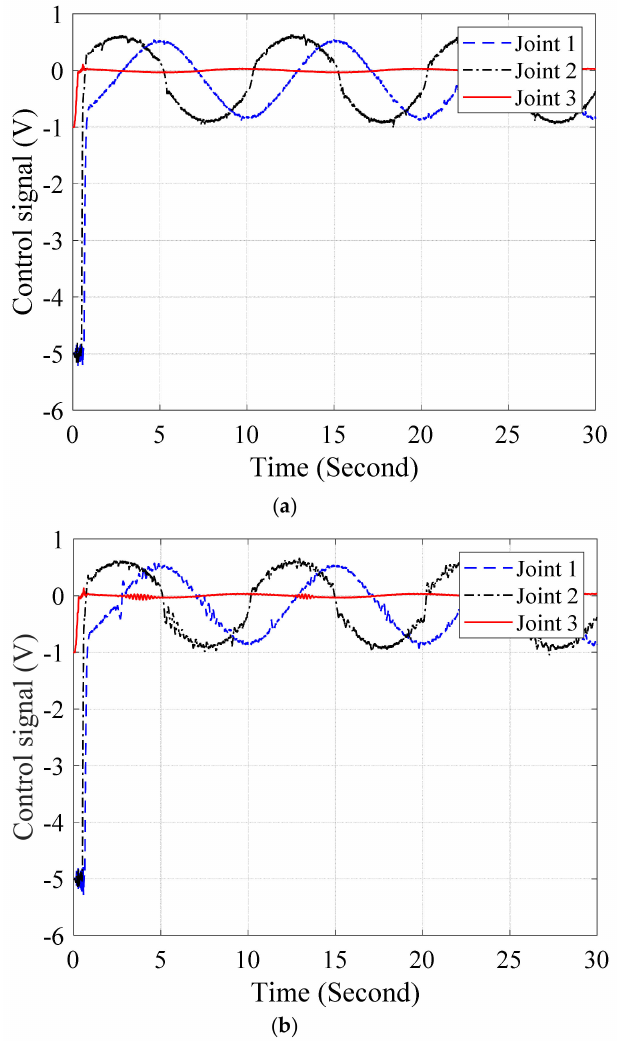
Figure 14. Control efforts of ( a ) BSMC and ( b ) proposed control with